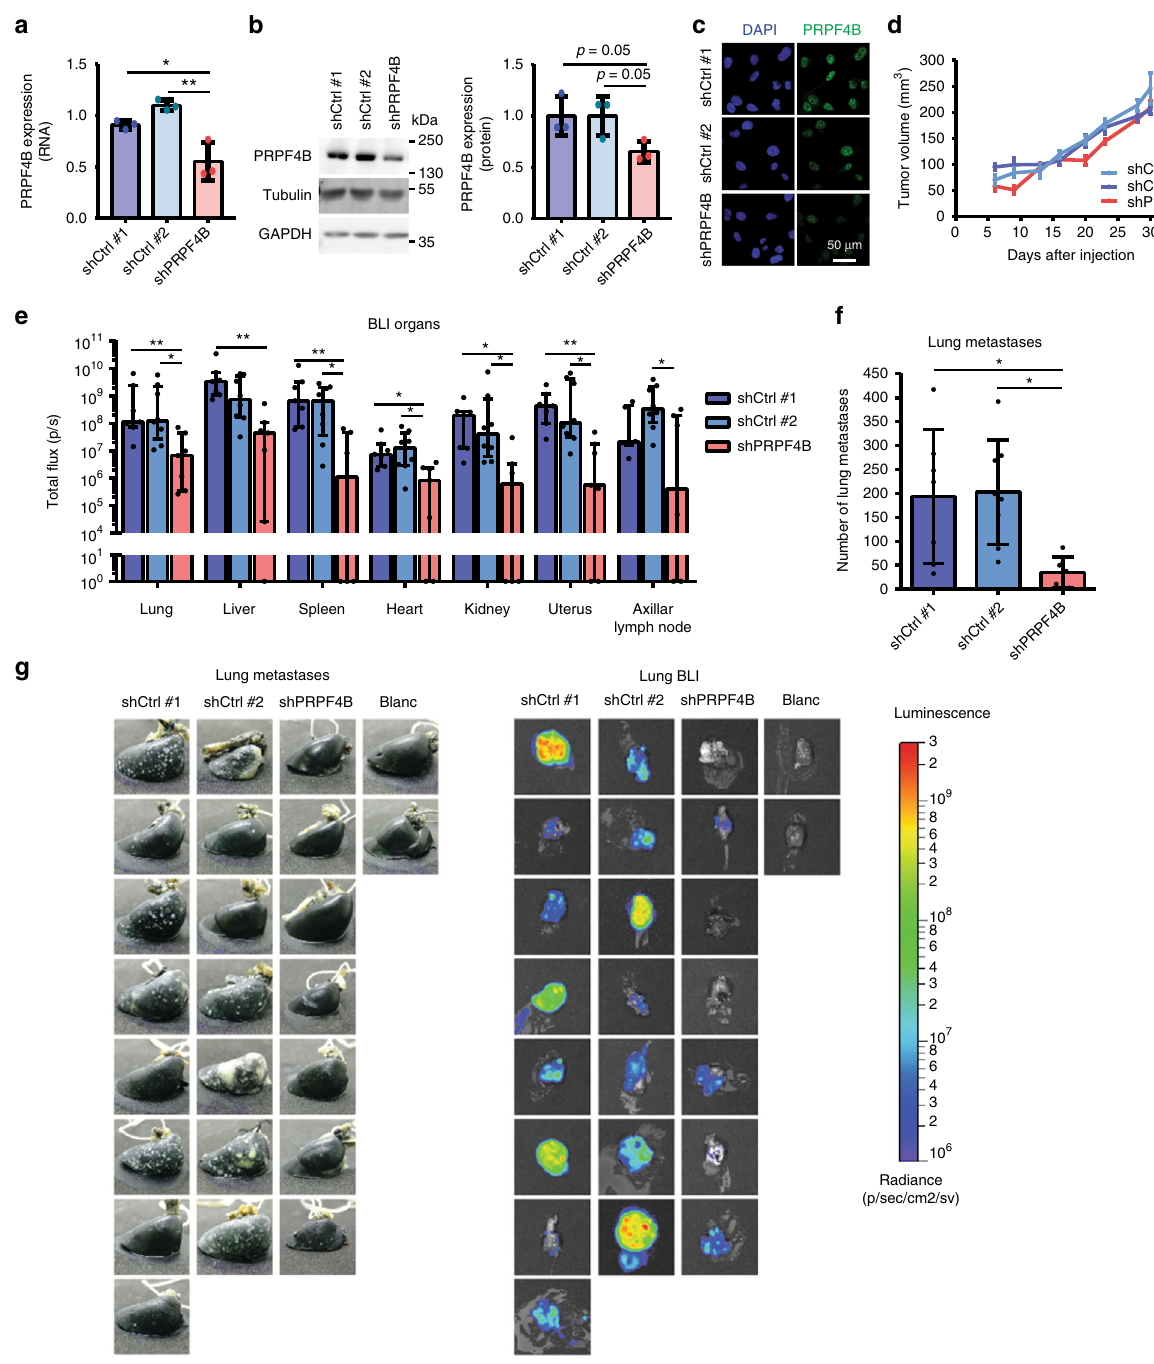
Fig. 7 PRPF4B is essential for breast cancer metastasis formation in vivo. a mRNA and b protein expression of PRPF4B in shPRPF4B MDA-MB-417.5 cell line compared to shCtrl#1 and shCrtl#2 MDA-MB-417.5 cell lines. Mean + s.d. of three biological replicates. Statistical signi fi cance was determined using one- way ANOVA correcting for multiple testing. * p < 0.05, ** p < 0.01. c Immuno fl uorescent staining for PRPF4B (green) and DNA (DAPI; blue) in shCtrl#1, shCtrl#2 and shPRPF4B MDA-MB-417.5 cell lines. Scale bar = 50 μ m. d Tumor growth of sh PRPF4B , shCtrl#1, and shCtrl#2 MDA-MB-417.5